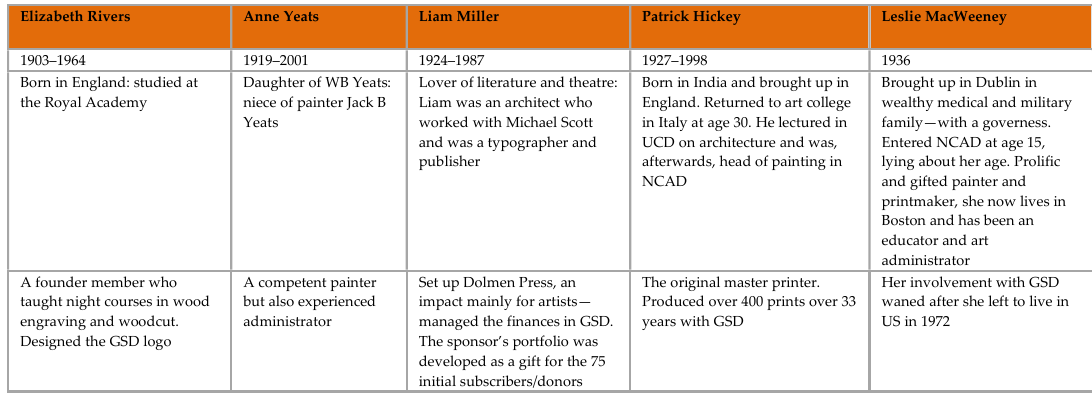
Figure 3. Founders of Graphic Studio Dublin 1960.